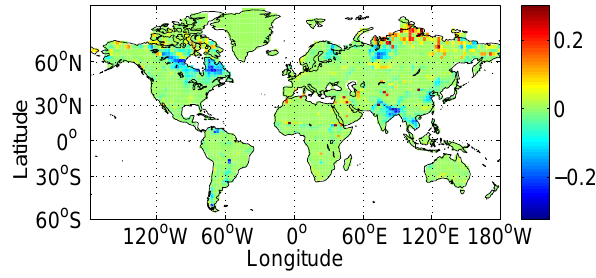
Fig. 3. Difference between mean June–September observed and simulated